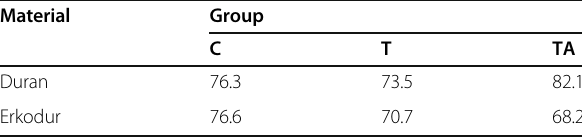
Table 3 Static glass transition temperature in each group